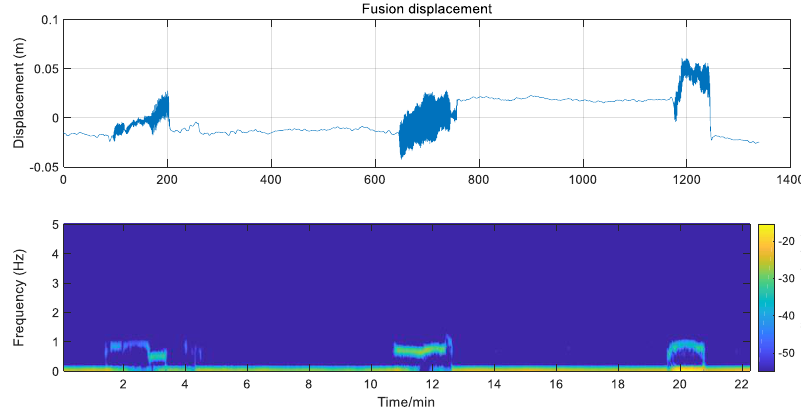
Figure 16. The fusion displacement of GNSS and speedometer.